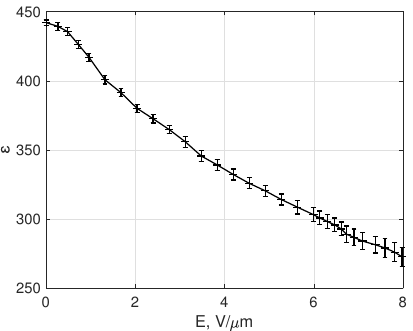
Figure 3. Experimentally measured FE permittivity dependence on the electric field strength. To minimize the insertion loss value, the ETM layer must be produced on the base of a thin-film or thick-film material with a high electrical resistivity. A resistive alloy containing Si-76%, Ti-20%, and Ce-4% (Si-Ti-Ce) was used as the ETM material in the reflector prototype. A wide range of thin-film surface resistivities was achieved by